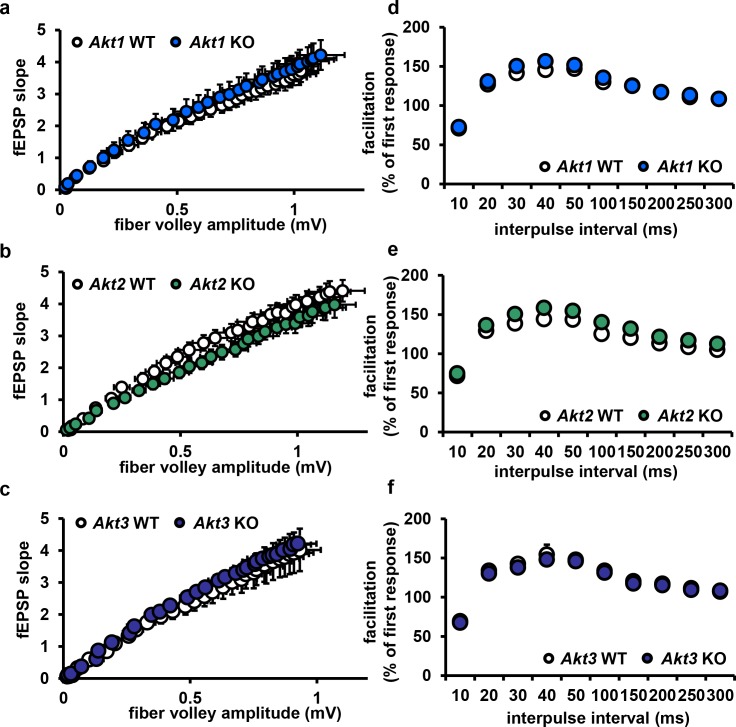
Deletion of single Akt isoforms has no effect on basal transmission or presynaptic plasticity.(a–c) Hippocampal slices from Akt1, Akt2 or Akt3 KO mice show normal basal transmission measured by input-output responses compared to WT mice (p>0.05). (d–f) Akt1, Akt2 or Akt3 KO slices show normal presynaptic plasticity measured by paired-pulse facilitation responses compared to WT slices (p>0.05), n = 11–19 slices, 5–7 mice/group.